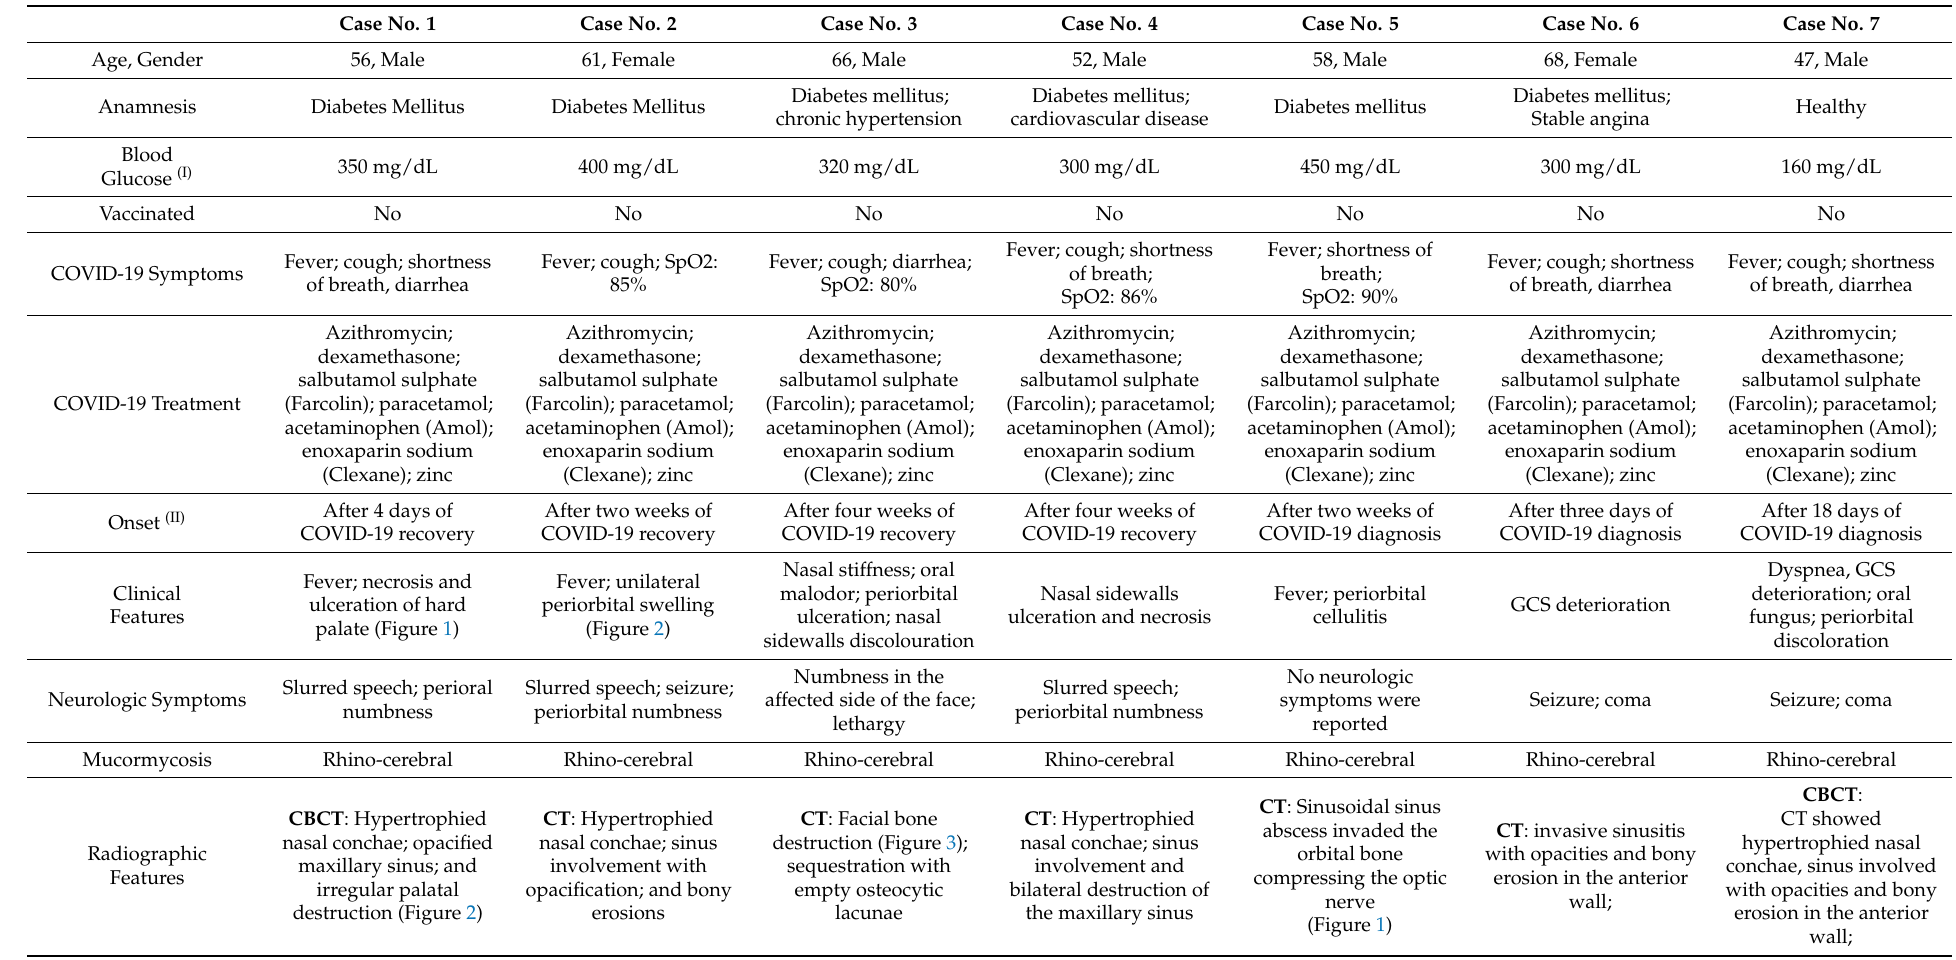
Table 1. Anamnestic, Clinical, and Paraclinical Features of COVID-19-associated Mucormycosis Cases in Egypt. Case No.